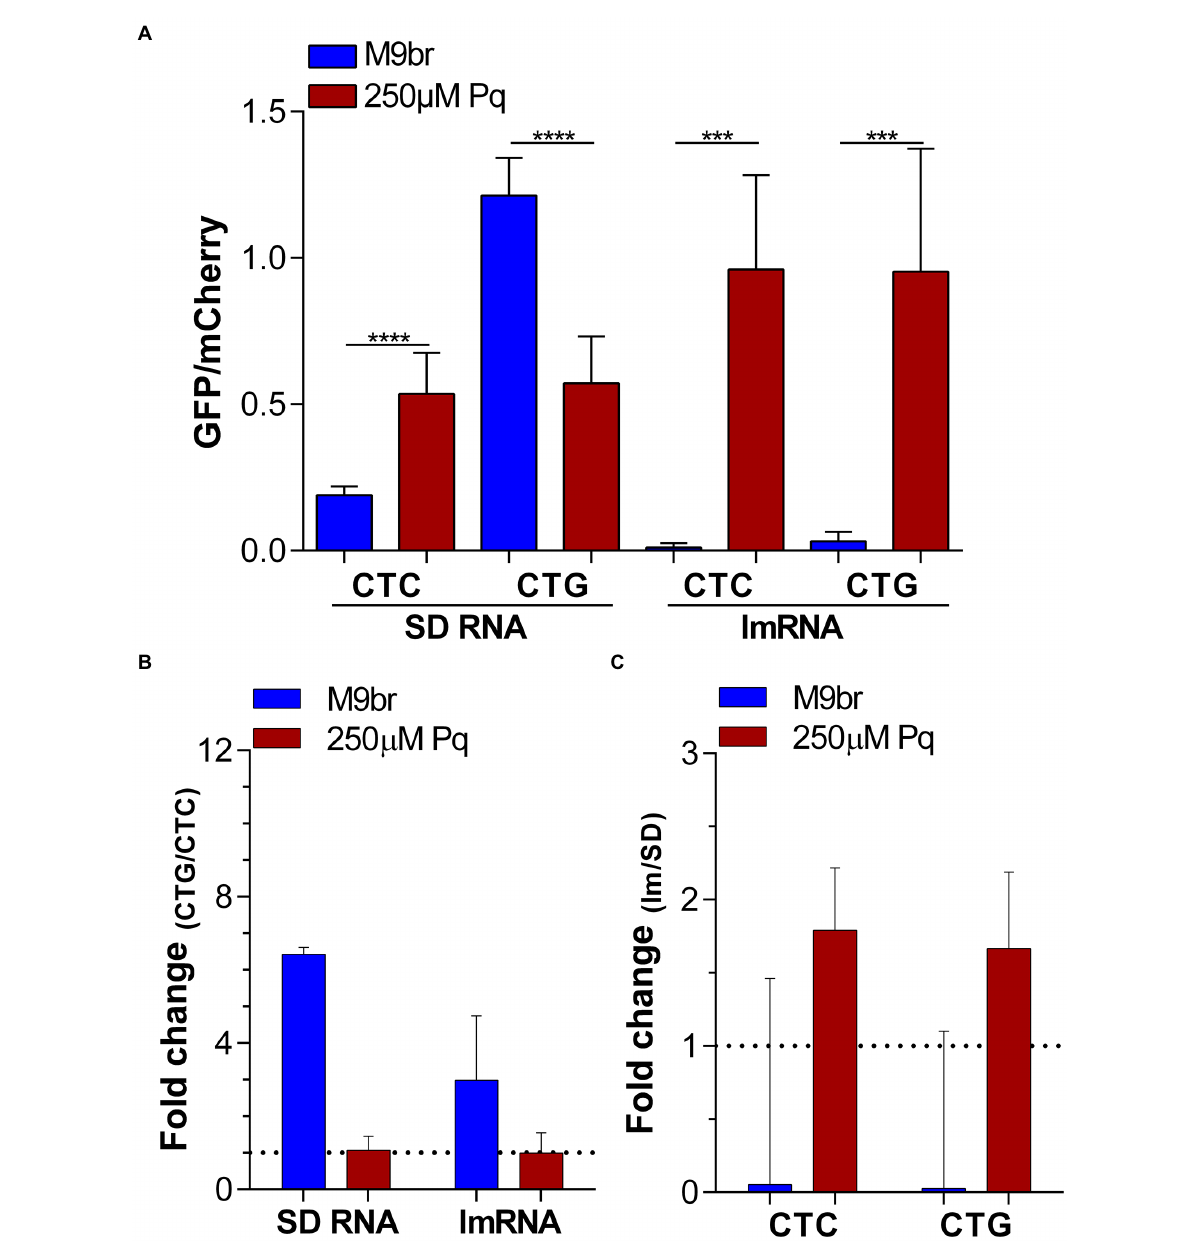
FIGURE 4 Altering translation initiation affects GFP synthesis under oxidative stress. (A) Ratios between GFP and mCherry synthesis under control and oxidative stress conditions were measured using reporters enriched in CTC and CTG Leu codons in the context of Shine-Dalgarno (SD RNA) and leaderless (lmRNA) translation. The ratios between these values are shown in (B) to highlight the effect of changing codons in the reporters and in (C) to highlight the effect of changing the translation initiation mechanism without altering codon choice. Statistical analyses: unpaired two